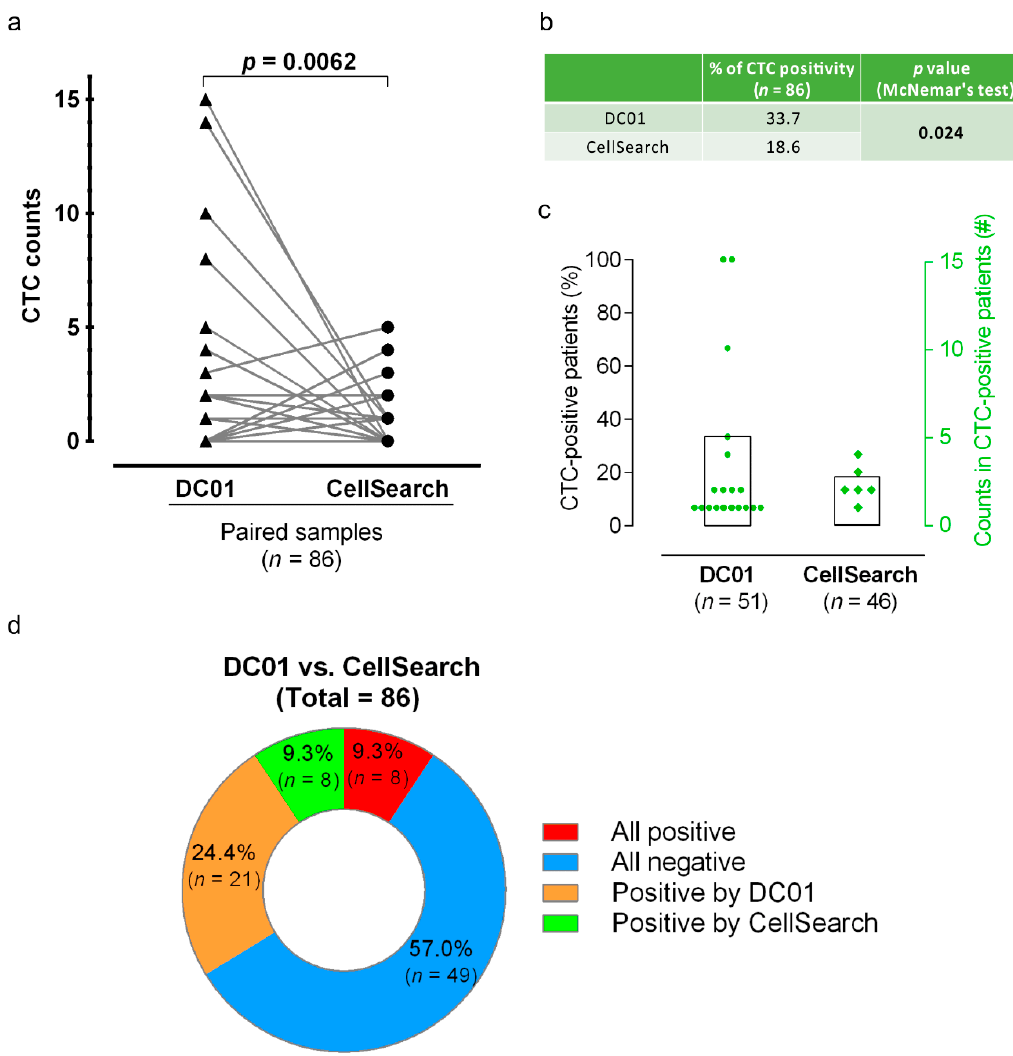
Figure 5. Comparison of circulating tumor cell (CTC) positivity and CTC counts examined by the two CTC detection methods. ( a ) Comparison of CTC numbers by parallel analysis of patient samples using DC01 and CellSearch. The plot links the number of CTCs detected by means of parallel enumeration using DC01 and CellSearch. DC01 detected significantly higher numbers of CTCs than CellSearch (Wilcoxon matched-pairs signed-rank test, two-tailed, p = 0.0062). ( b ) Comparison of CTC positivity of both methods ( p < 0.05 statistically significant, McNemar's test). ( c ) Percentage of CTC-positive patients (bars, 33.7% and 18.6%) and number of CTCs detected per patient (dots, squares) listed for the parallel analysis in 51 patients using DC01 and CellSearch, respectively. ( d ) Concordance between the two CTC detection methods. Assays were not concordant if CTC status of one sample was differently detected by each method, meaning one assay was positive and the other negative (orange/green). Assays were assumed as concordant when CTC status was the same for one sample detected by both techniques (all positive <red> or all negative <blue>).